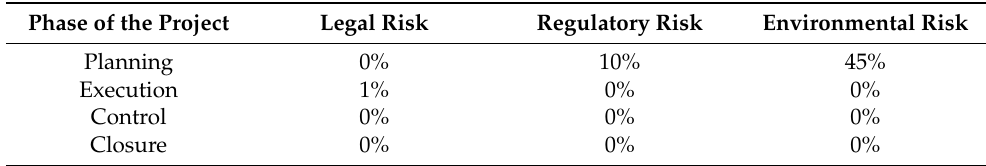
Table 8. Assessment of legal, regulatory and environmental risks in the different phases of CHP projects.